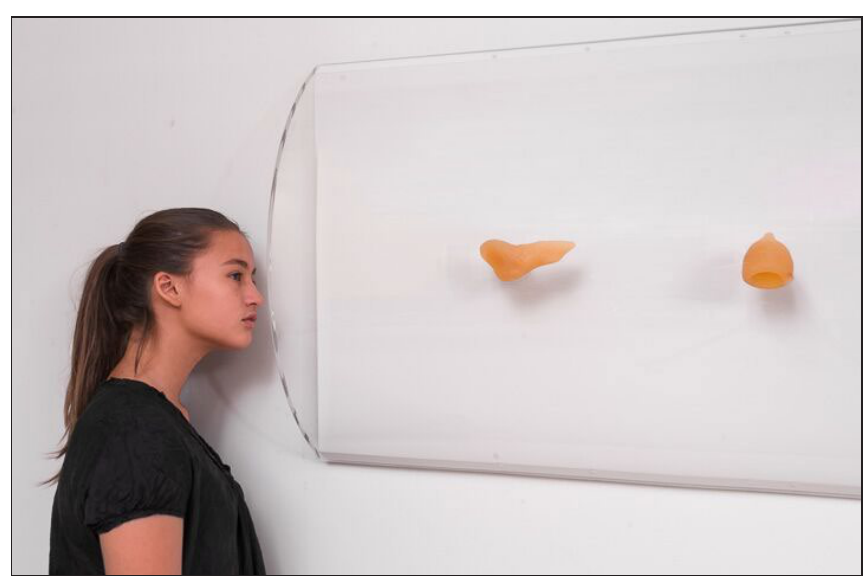
Figure 33: Iris Anna Regn and Rebecca Niederlander for Los Angeles County Arts Collection, Detail of installation BROODWORK: Mending, Cast urethane, stainless steel, acrylic, fiberglass, 2015 (Photo by Steve